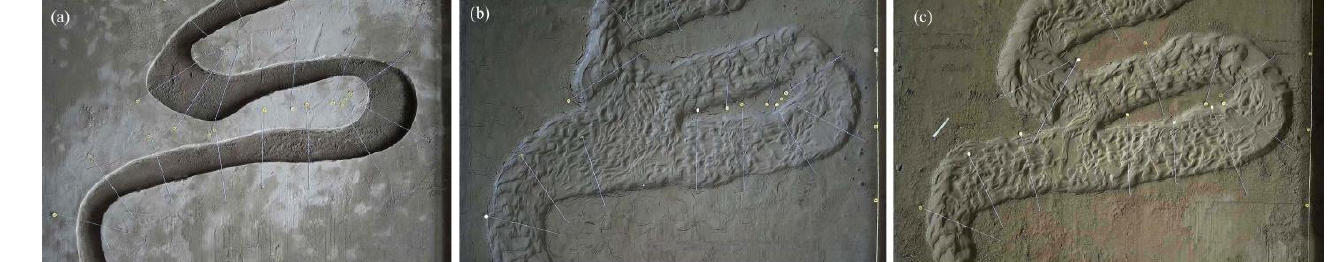
Figure 9. Comparison between ( a ) the initial terrain and the final terrain after cutoff with ( b ) the topography of the relative equilibrium in RUN2 and ( c ) the topography of the relative equilibrium in RUN3. The white line represents the measured cross section. The yellow line on the right marks the length.